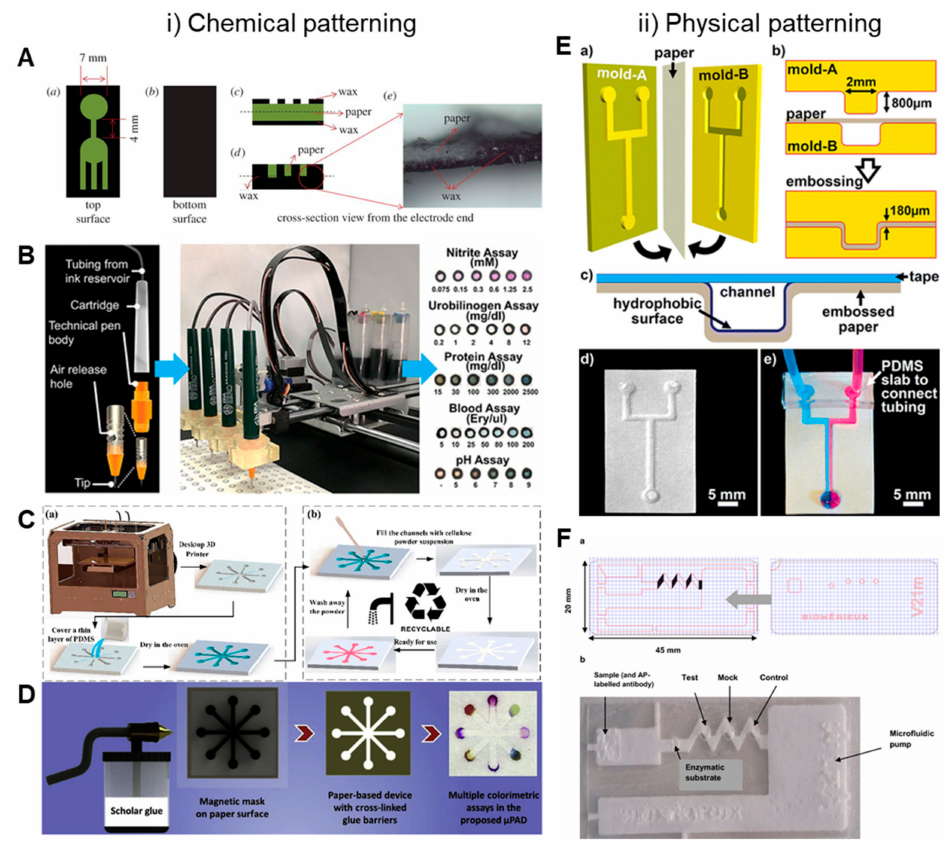
Figure 2. Recent 2D paper-based microfluidic devices. i ) Chemical patterning: ( A ) double-sided wax printing (Suresh et al., reprinted with permission from ref [25]. Copyright 2018, the Royal